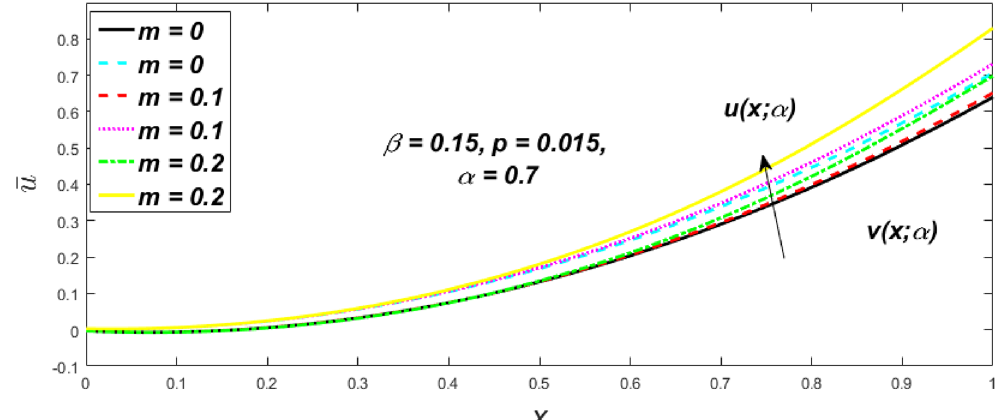
Figure 34. Fuzzy velocity for the impact of m.